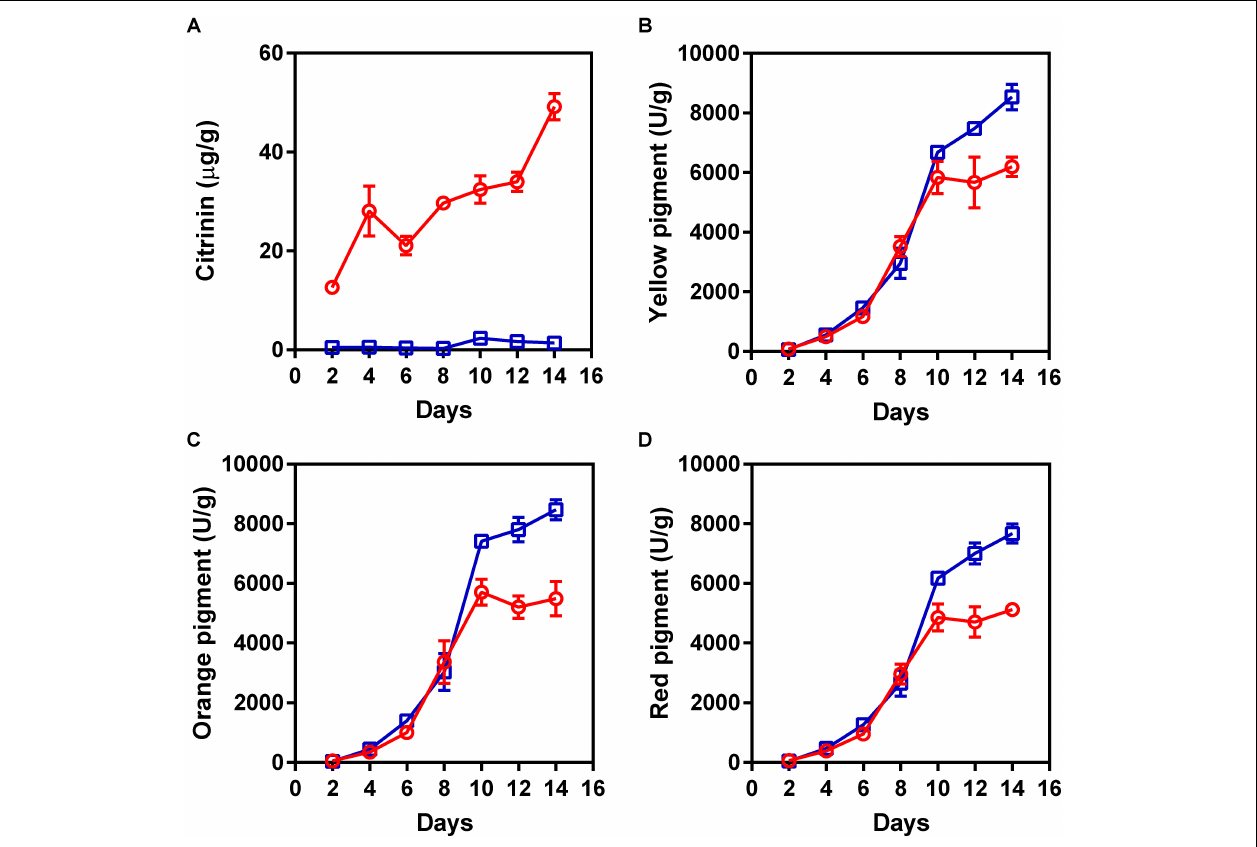
FIGURE 1 | The production of pigments and citrinin by the Monascus purpureus YY-1 and winter strains. (A) Citrinin, (B) yellow pigment, (C) orange pigment, and (D) red pigment. The red and blue lines represent the YY-1 and winter strains, respectively. The error bars indicate the standard deviations of three independent